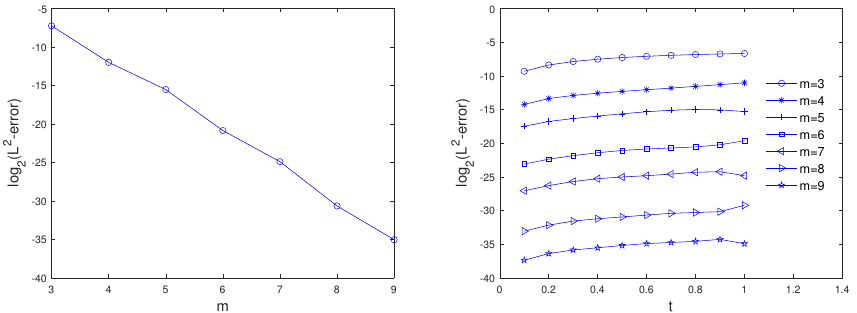
Figure 3. Effect of the parameter m on L 2 –errors, with β = 0.6, for Example